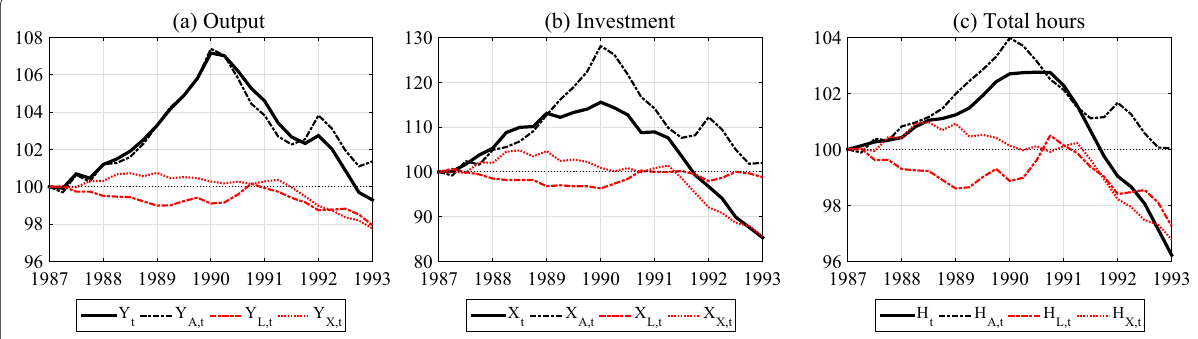
Fig. 4 Aggregates and their wedge-alone components 1987Q1–1993Q1. The subscripts A , L , X denote the efficiency-, labour-, and investment-wedge-alone component of output Y t , investment X t , or total hours H t